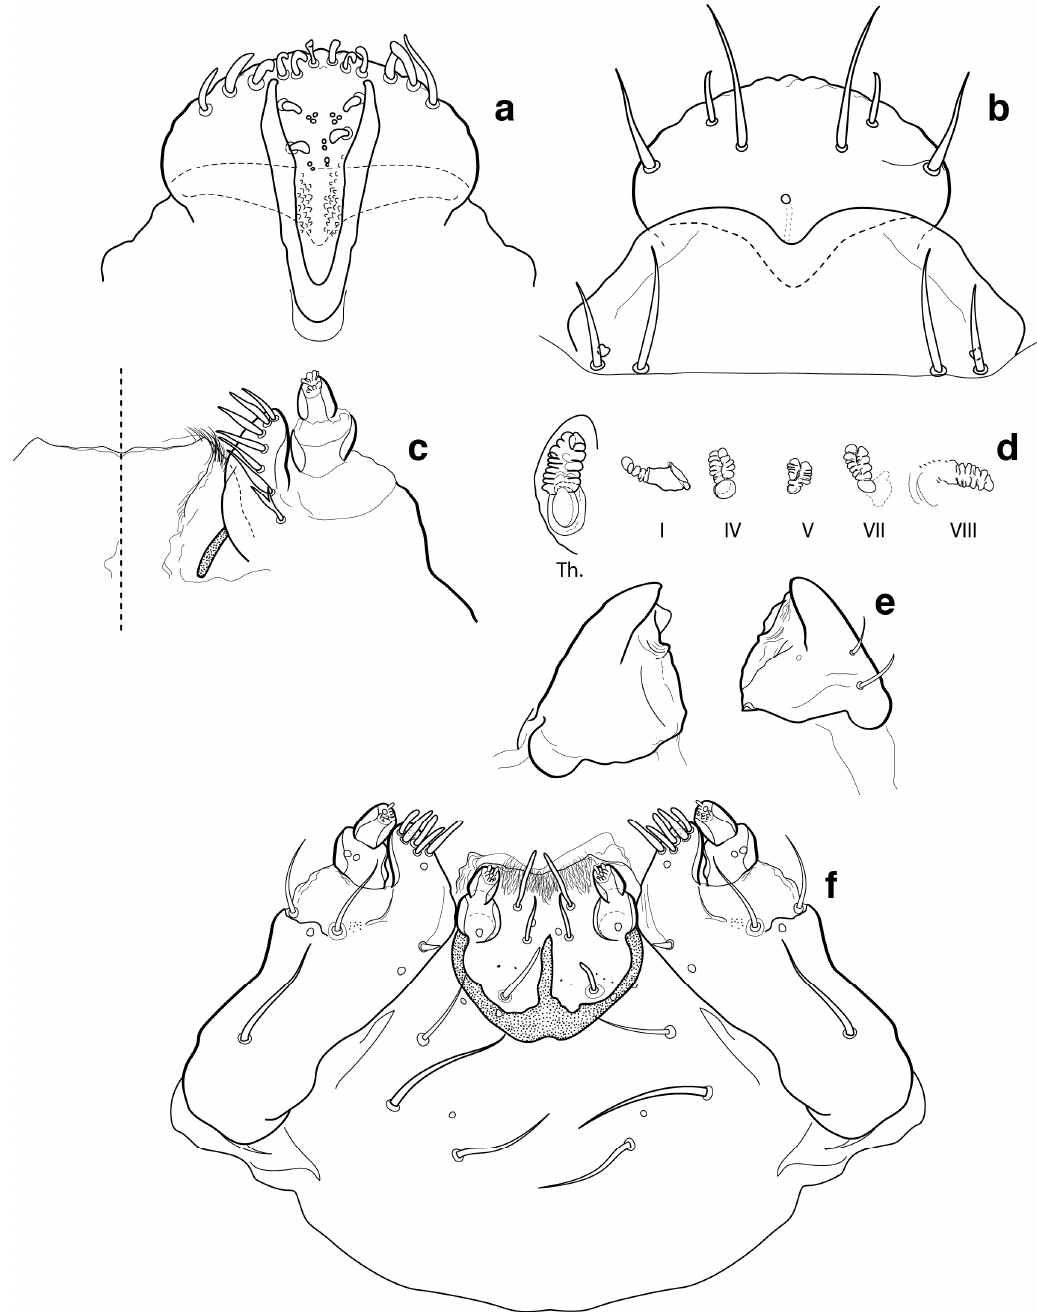
Figure 68. Myocalandra sp. Mouthparts: ( a ) epipharynx; ( b ) clypeus and labrum; ( c ) maxillae and hypopharynx, dorsal view; ( d ) spiracles; ( e ) mandibles; and ( f ) labio-maxillary complex, ventral view.